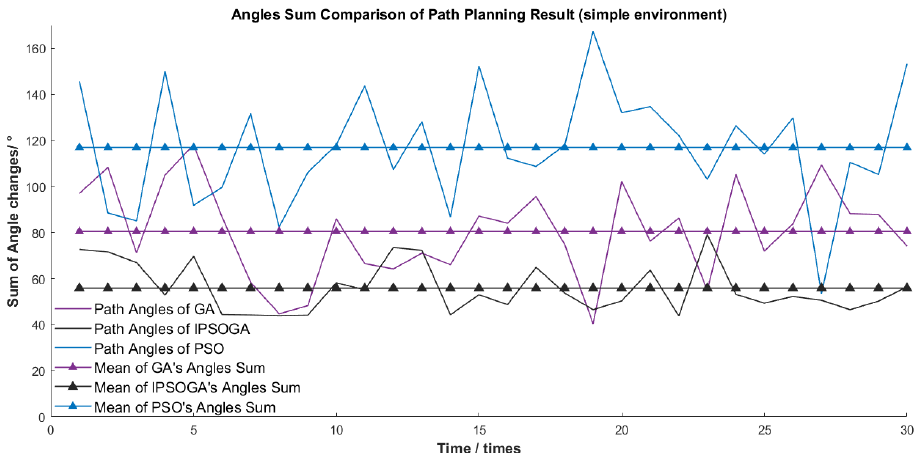
Figure 13. Comparison of Path Angle Sum (simple environment).